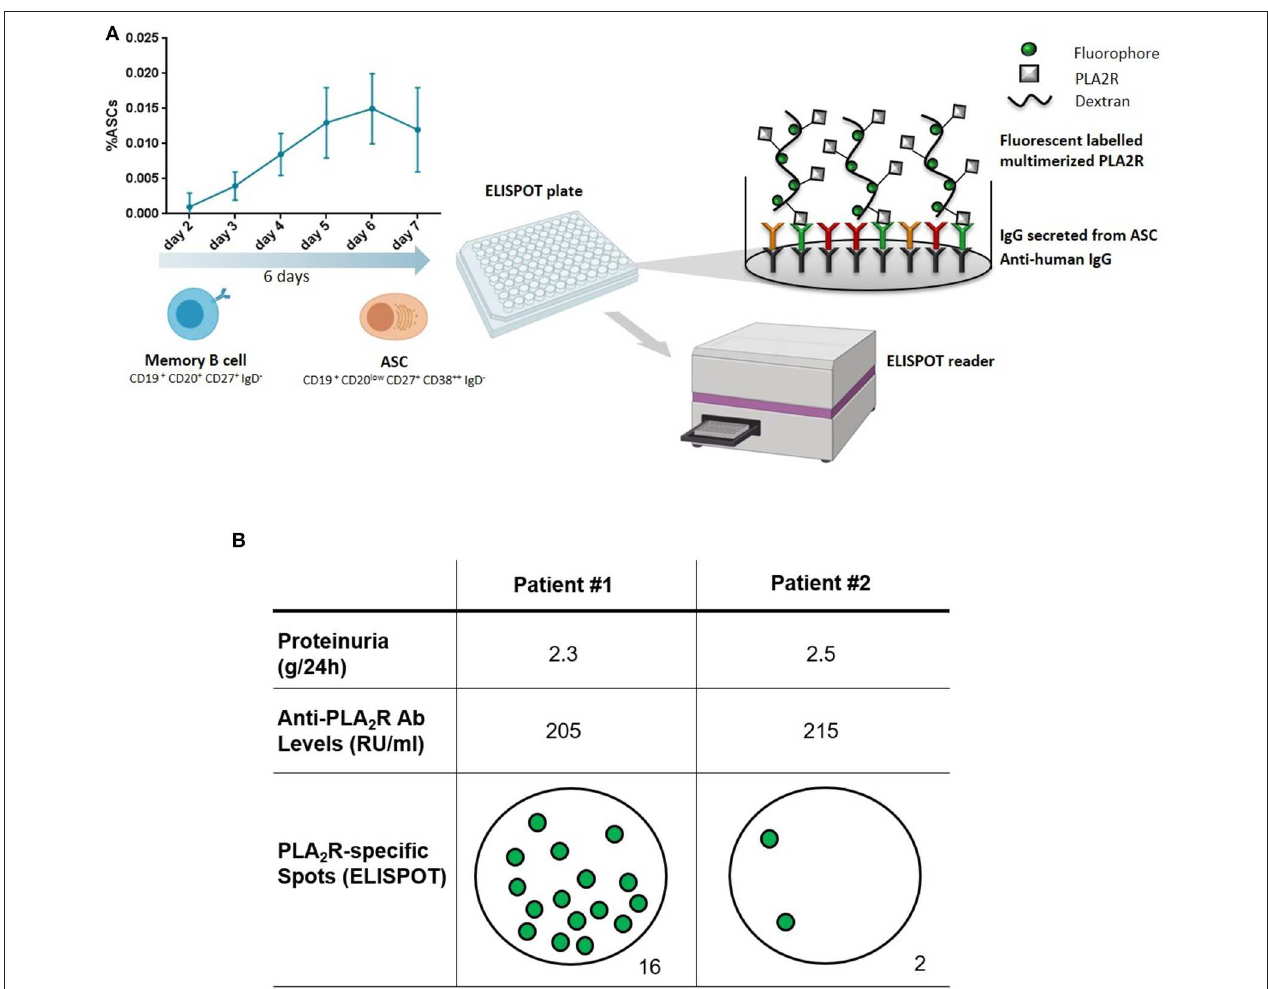
FIGURE 2 | Measuring anti-PLA 2 R reactive memory B cells. (A) Peripheral blood mononuclear cells are first polyclonally activated for 6 days to expand the pool of memory B cells and antibody secreting cells (ASC). Expanded cells are next used for an enzyme-linked immune absorbent spot (ELISPOT) assay to detect cells producing antibodies against PLA 2 R. (B) Two representative patients with membranous nephropathy and similar levels of proteinuria and circulating anti-PLA 2 R antibodies. Patient #1 has a positive ELISPOT, indicating the presence of autoreactive memory B cells (sign of active disease), while Patient #2 has no detectable autoreactive memory B cells (indicative of a remission phase). Adapted from Luque et al.